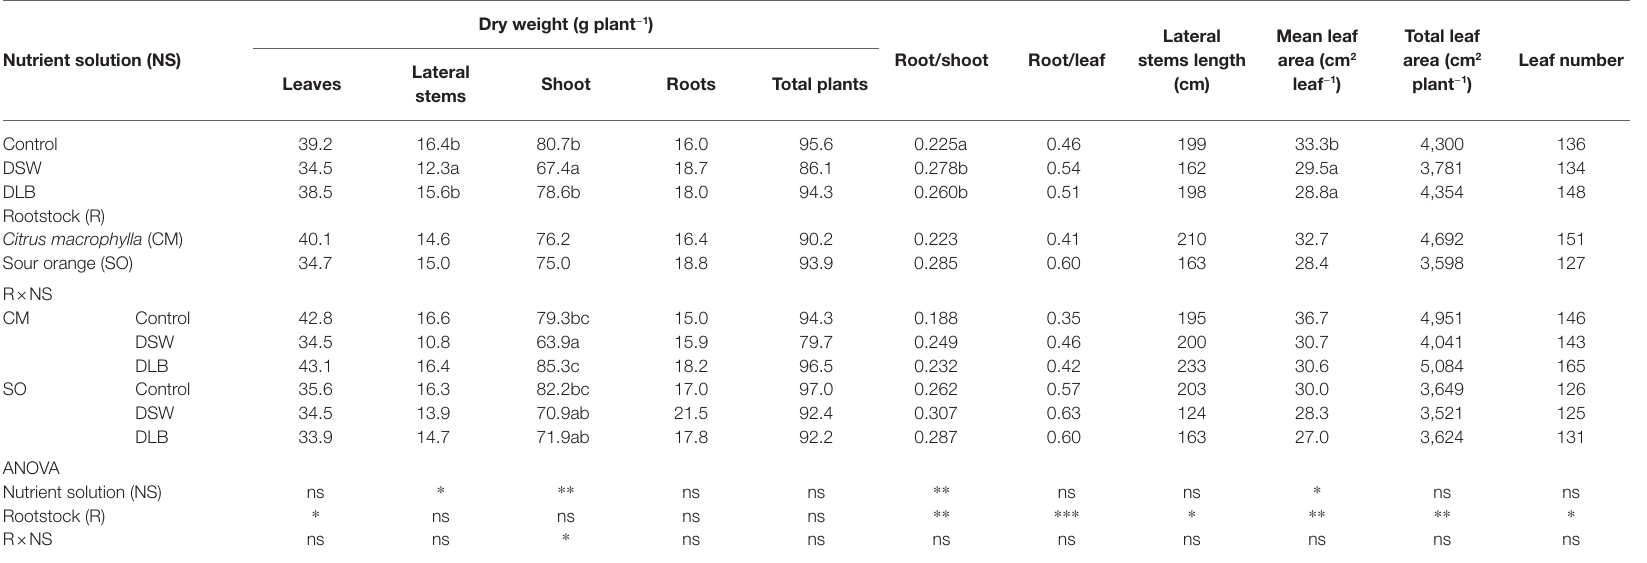
TABLE 3 | Effects of 7 months of irrigation with nutrient solutions of different characteristics—Control, DSW, and DLB—and the rootstock on different parameters of the growth, and on the root/shoot weight ratio, of ‘Verna’ lemon plants grown on two rootstocks, Citrus macrophylla (CM) and sour orange (SO).